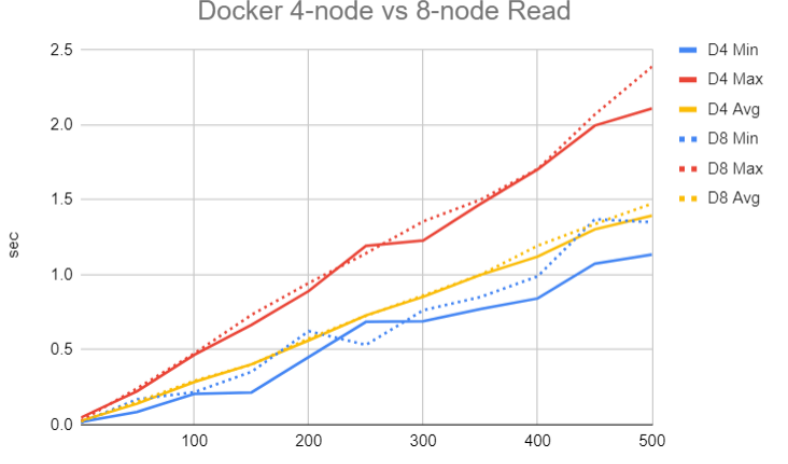
Figure 5. Latency of read TXs (in seconds) measured with a local Indy-based BC and different arrival rates